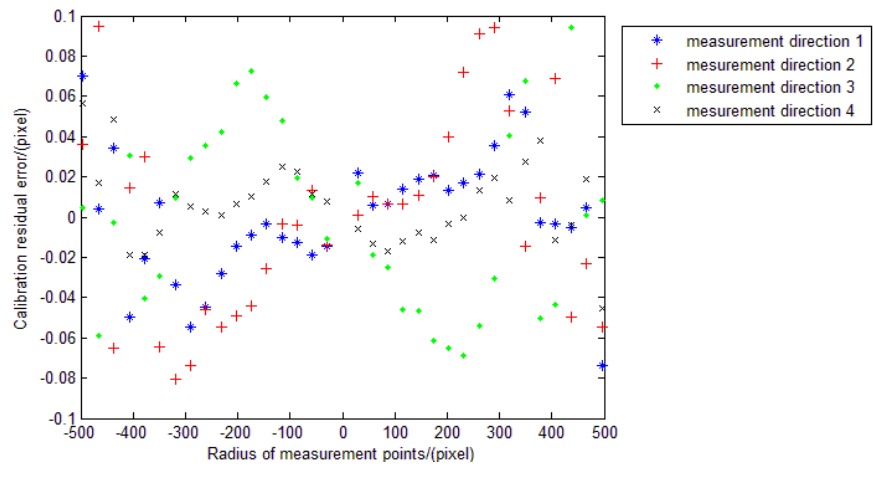
Figure 25. Calibration residual